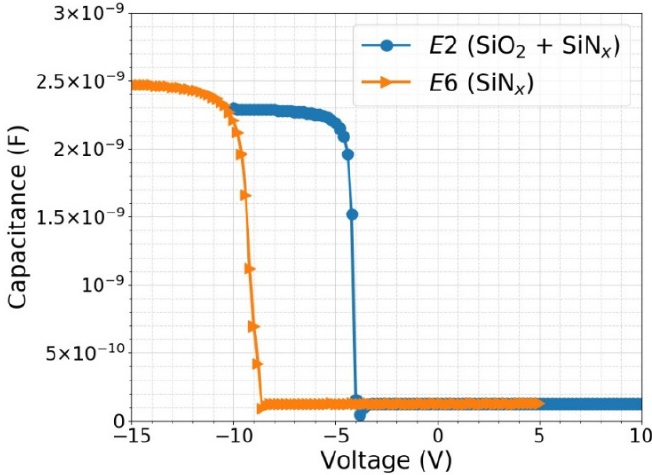
Figure 10. Capacitance—voltage (C—V) measurement results of MIS capacitors prepared with the passivation processes E2 (6 nm SiO 2 + 65 nm SiN x ) and E6 (65 nm SiN x ) as described in Table 1, at a frequency of 1 kHz.